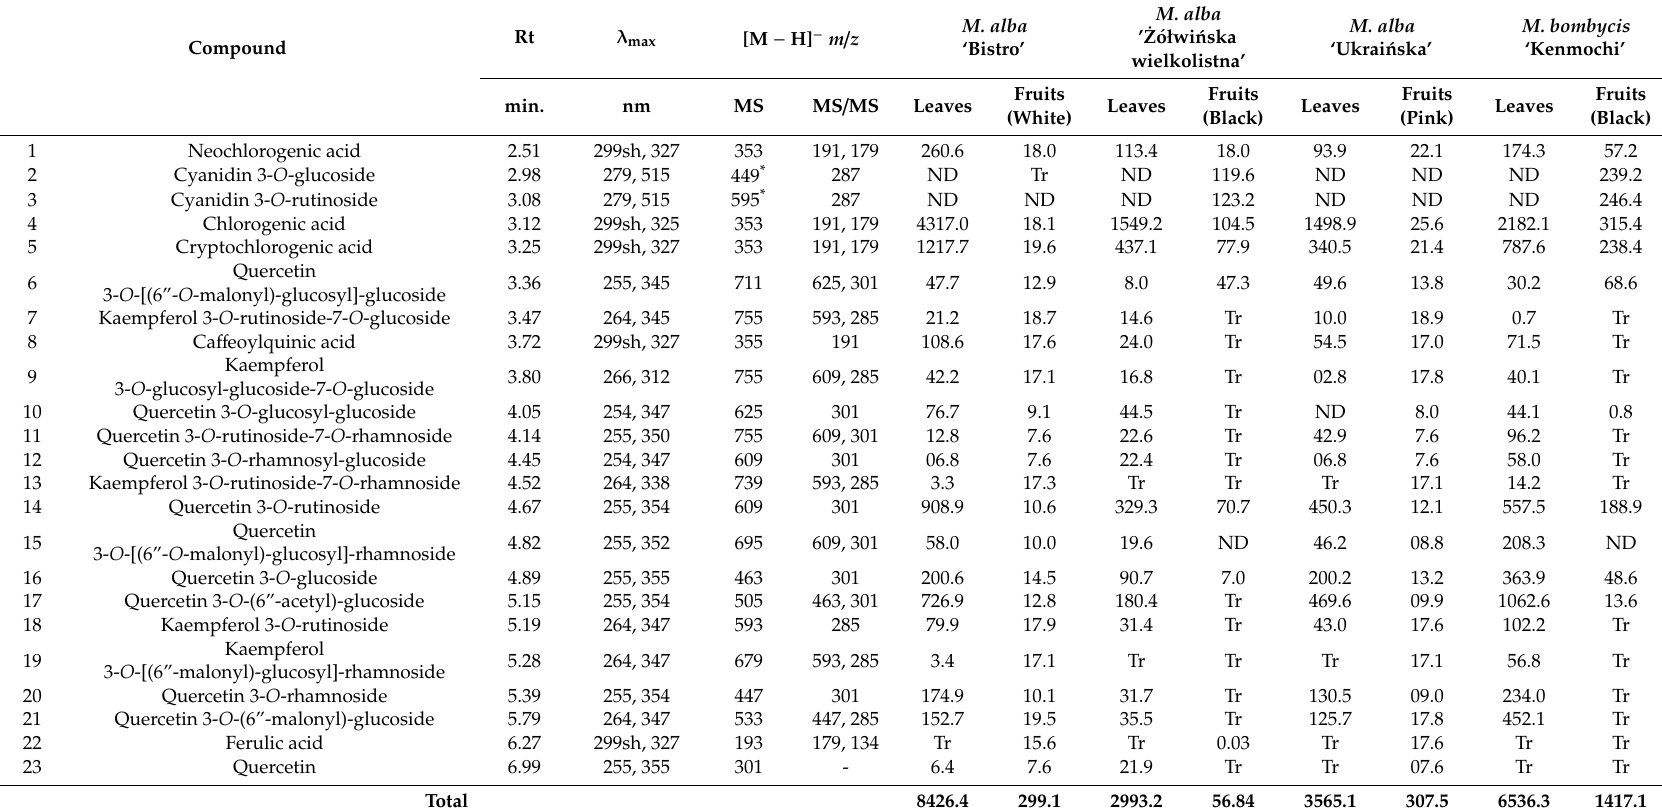
Table 3. Individual phenolic compounds (mg / kg) identified by ultra-performance liquid chromatography coupled with a mass spectrometer (UPLC-PDA-ESI-MS) in mulberry leaves and